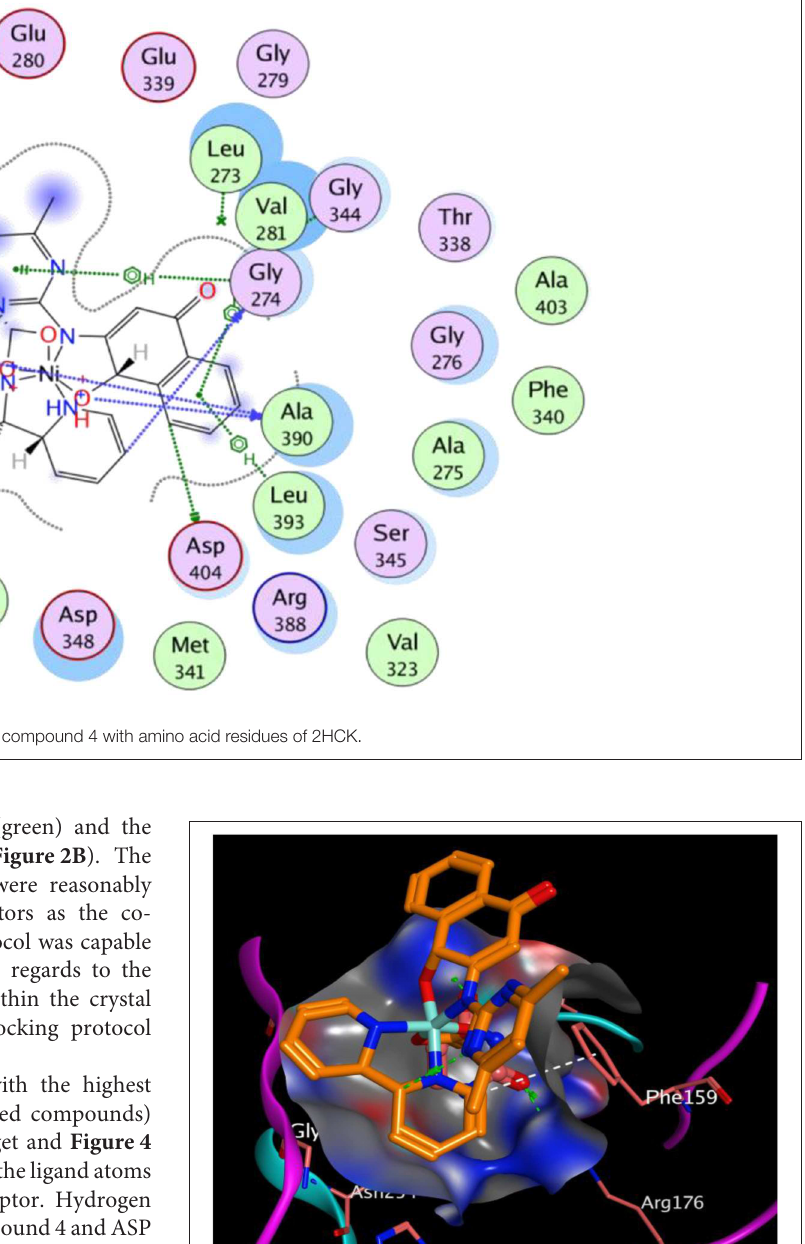
the desired pharmacological activity. Hence binding outside the binding sites has no effects. At this binding sites lies different amino acid residues that chemically interact with the atoms of the ligand. We observed that our compounds properly fitted into the binding sites of the receptor when compared with the co-crystallized ligand. The chemical interactions between the π electrons from three different 6-membered